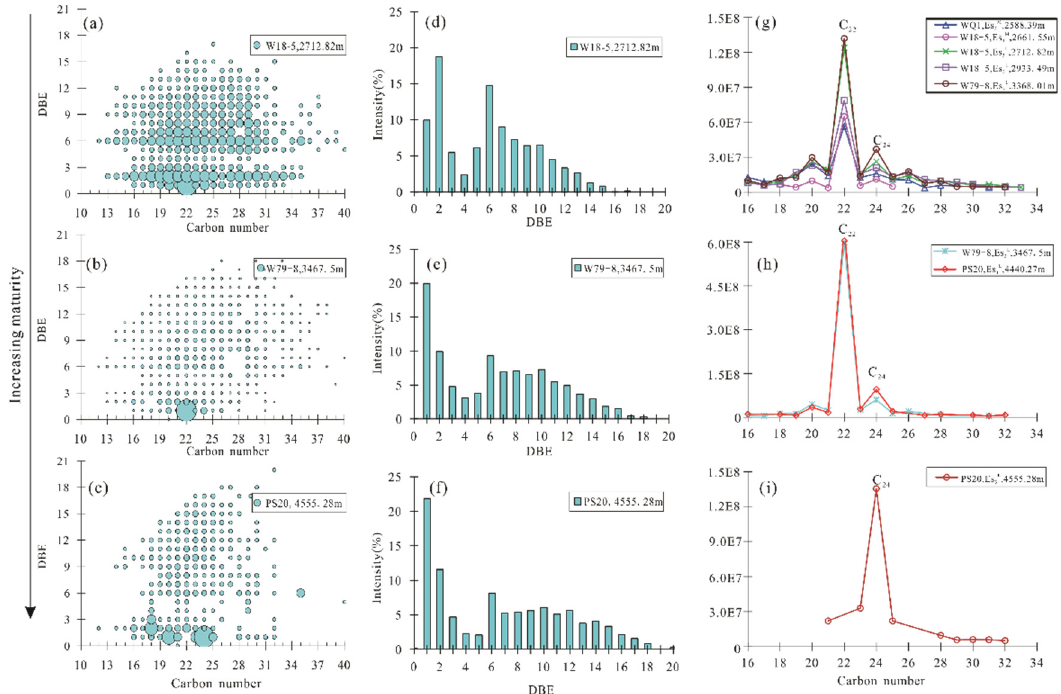
Figure 9. The relationship between the carbon number and DBE ( a – c ), the relative abundance of different DBEs ( d – f ), and the carbon number and abundance distribution of DBE = 1, 2, and 6 ( g – i ) of O 3 type that were observed by negative ion ESI FT-ICR MS in the source rocks of the Dongpu Depression.